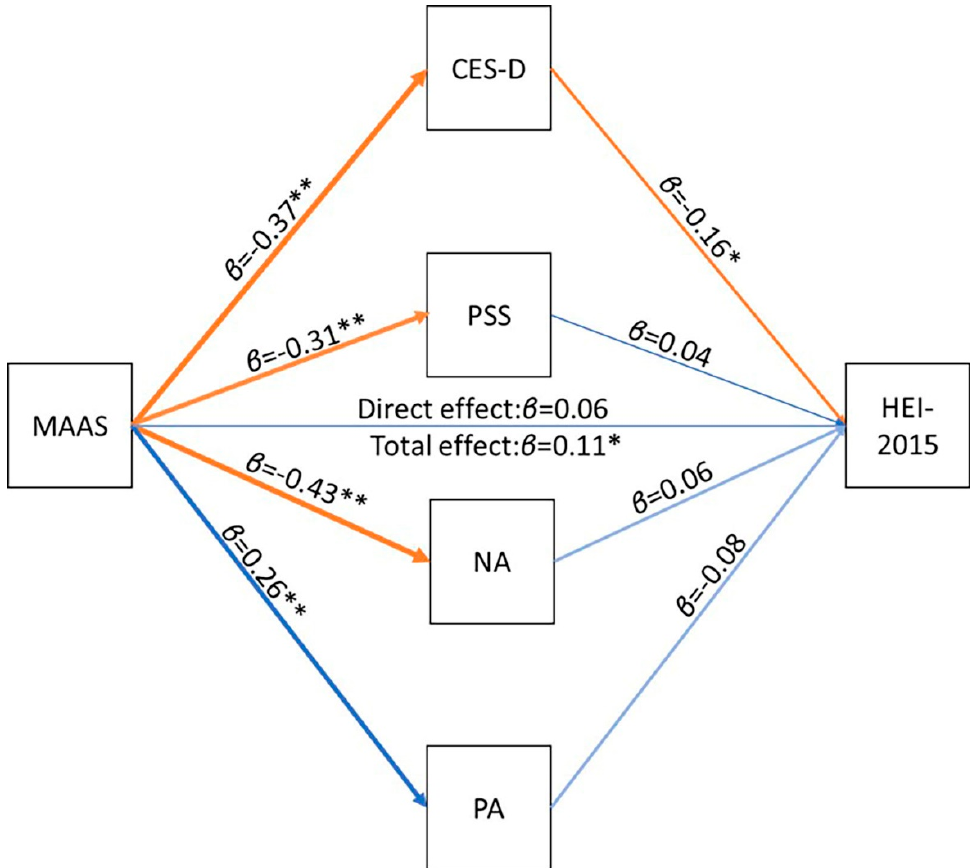
Figure 2. Diagram of path model of the e ff ect of MAAS scores on HEI-2015 total scores. Note: MAAS = Mindful Awareness and Attention Scale; PSS = Perceived Stress Scale; CES-D = Center for Epidemiologic Studies Depression Scale; PANAS = Positive A ff ect Negative A ff ect Schedule; NA = negative a ff ect; PA = positive a ff ect; HEI = Healthy Eating Index. * p < 0.05 ** p < 0.01.